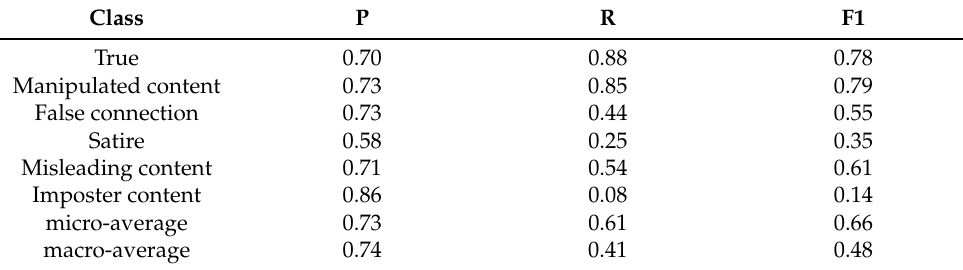
Table 6. Results of BiLSTM with random